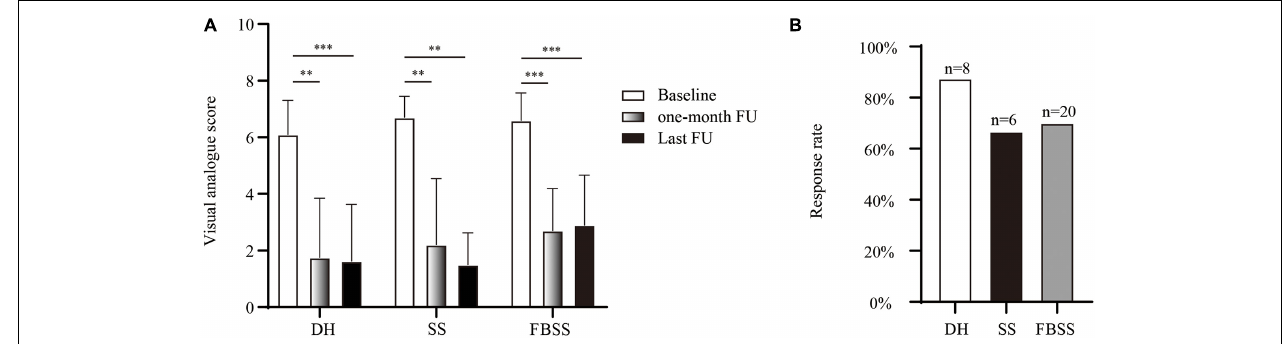
FIGURE 4 | The long-term therapeutic effect. (A) Comparison of pain degree assessed by visual analog scores. (B) The long-term response rate of the last follow-up. ∗∗ p < 0.01, ∗∗∗ p < 0.001.